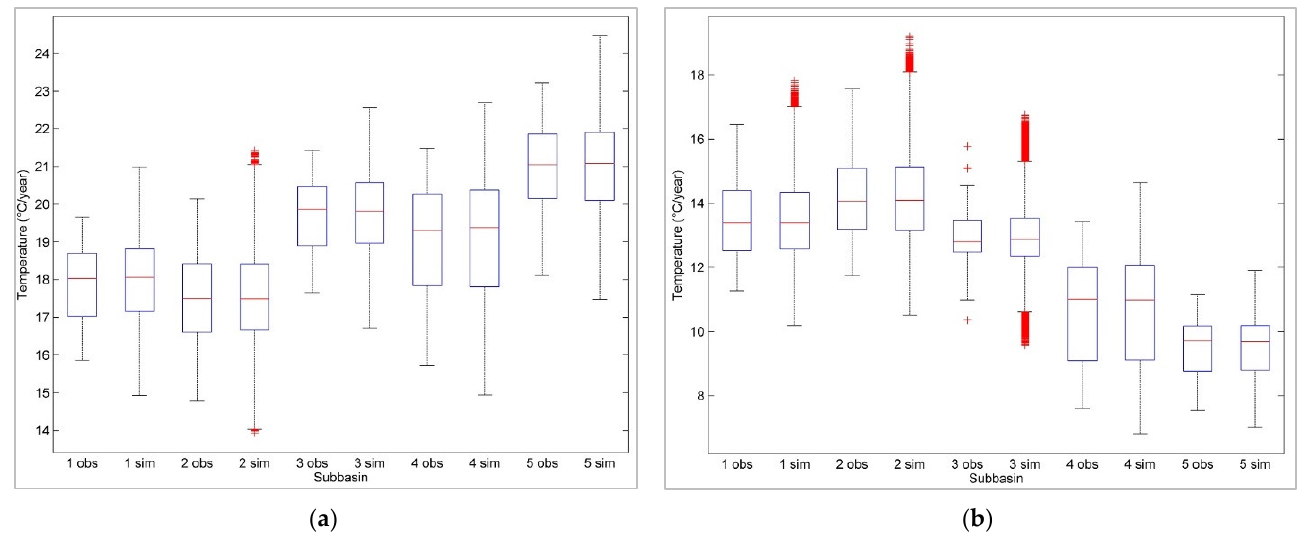
Figure 13. Yearly temperature for all sub-basins observed (obs) and simulated (sim) for ( a ) maximum temperature and ( b ) temperature range. (1) Alarcon, (2) Contreras, (3) Molinar, (4) Tous, and (5) Huerto Mulet. The outliers are plotted individually using the ‘+’ marker symbol. Table 4. Annual cross-correlation matrix for all sub-basins.